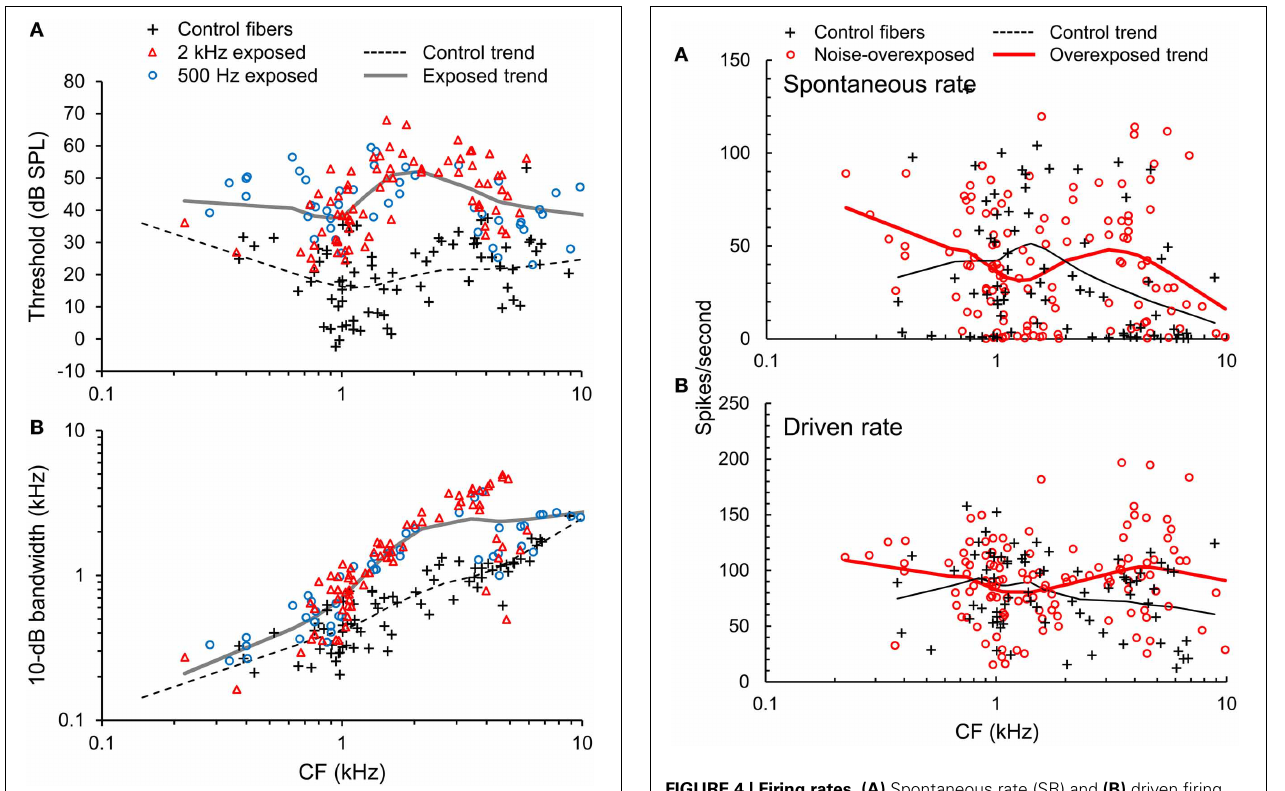
FIGURE 4 | Firing rates. (A) Spontaneous rate (SR) and (B) driven firing rate plotted as a function of CF in normal hearing and noise-overexposed auditory-nerve fibers. Trend lines are based on local regression analyses. At CFs above 2.5kHz, noise overexposure was associated with an increase in driven rate and decrease in the proportion of low-SR